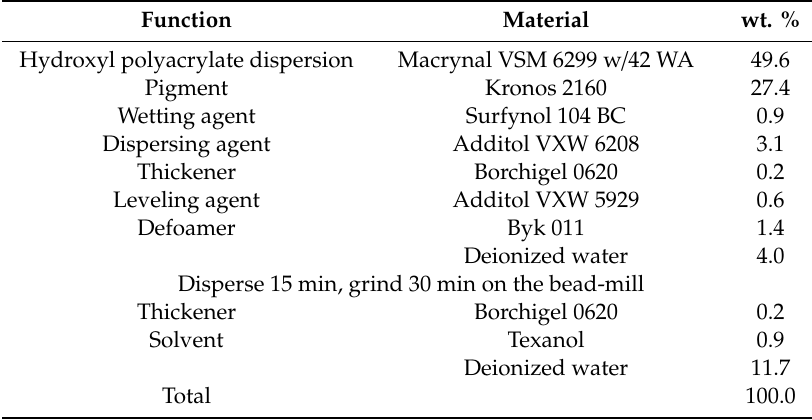
Table 2. Formulation of the waterborne polyurethane coating (base).